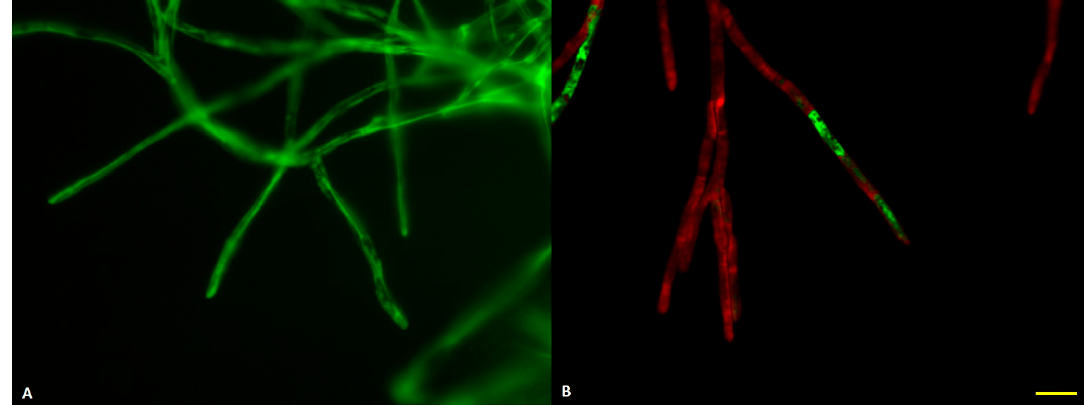
Figure 3. Viability staining of Irpex lacteus hyphae in 4 ( A ) and 8 ( B ) day old cultures. Green—metabolically active, red—inactive hyphae. Bar—10 µm.